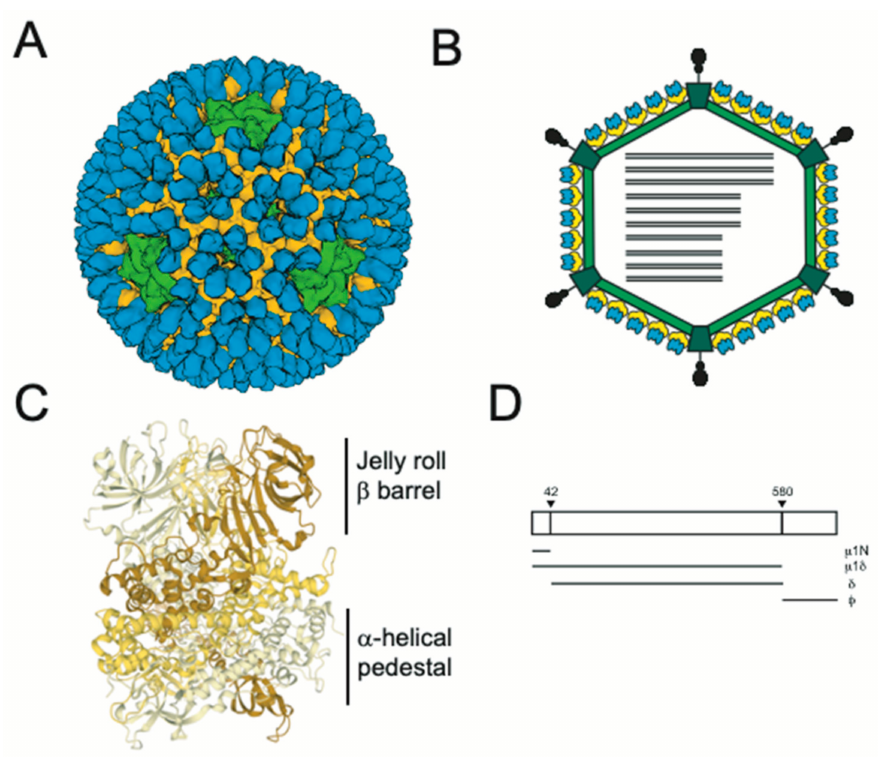
Figure 1. ( A ) Cryoelectron microscopy (cryoEM) structure of reovirus virions rendered from PDB 2CSE ( A ) and its schematic representation ( B ) are shown. Core proteins, µ 1, σ 3 and σ 1 are shown in green, yellow, blue and black, respectively. σ 1 is not resolved in the cryoEM structure. ( C ) A trimer of µ 1 is shown with each monomer in a shade of yellow. ( D ) Cleavage fragments of the µ 1 protein formed during the entry of virus particles into cells are